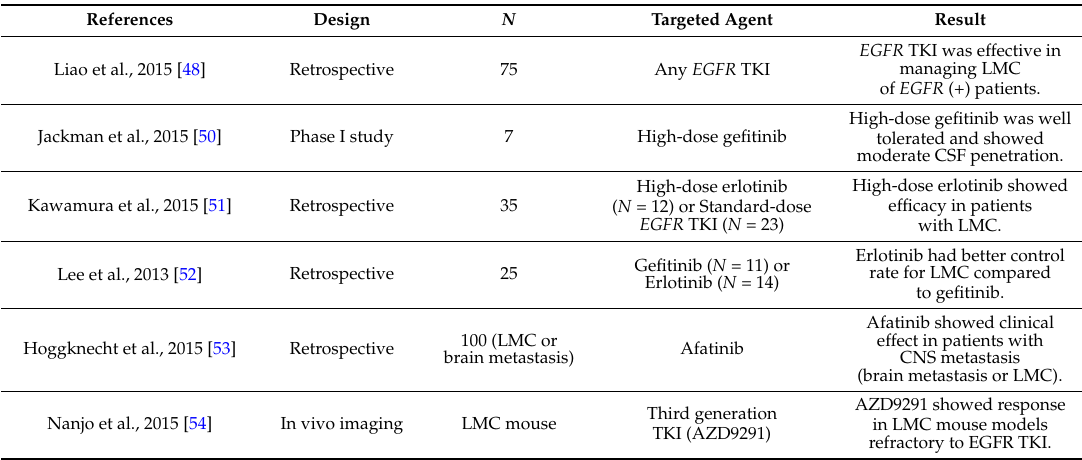
Table 1. Epidermal growth factor receptor ( EGFR ) TKI in EGFR (+) non-small cell lung cancer (NSCLC) with leptomeningeal